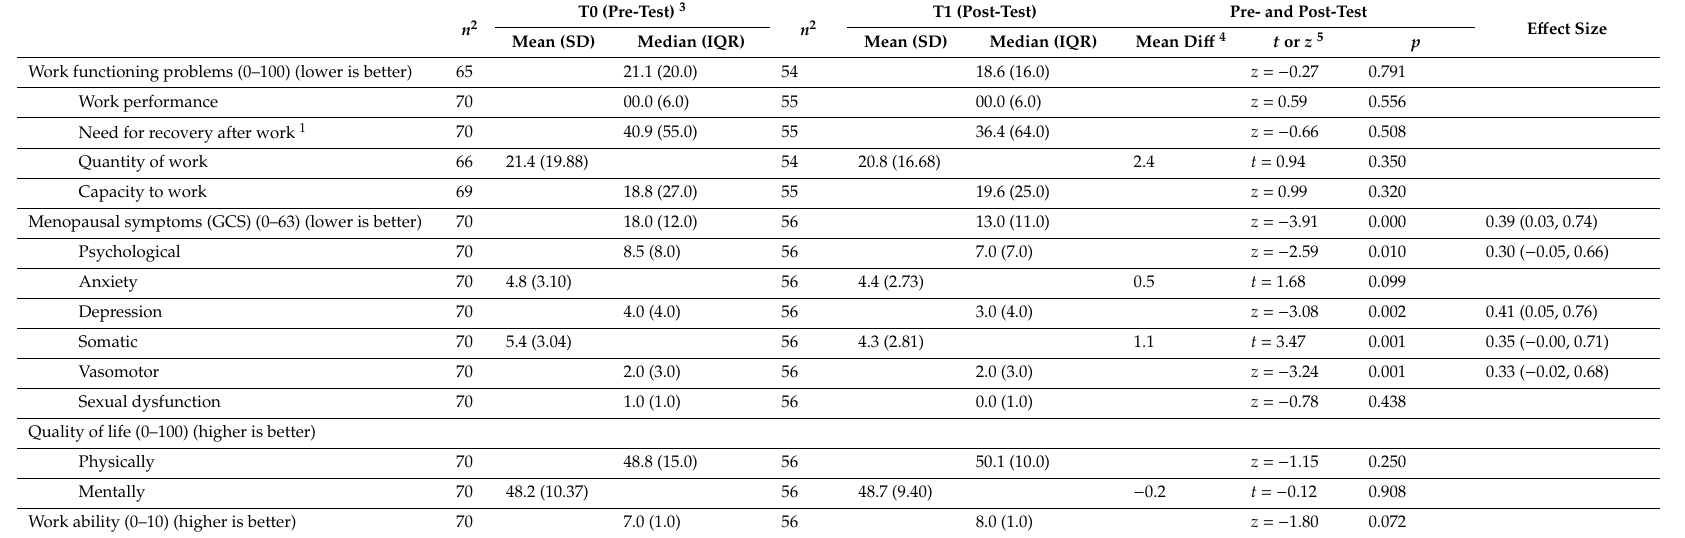
Table 3. Outcomes on pre-test–post-test, paired t -tests and Wilcoxon signed-rank test results, and e ff ect sizes. T1 T0 (Pre-Test) 3 n 2 n 2